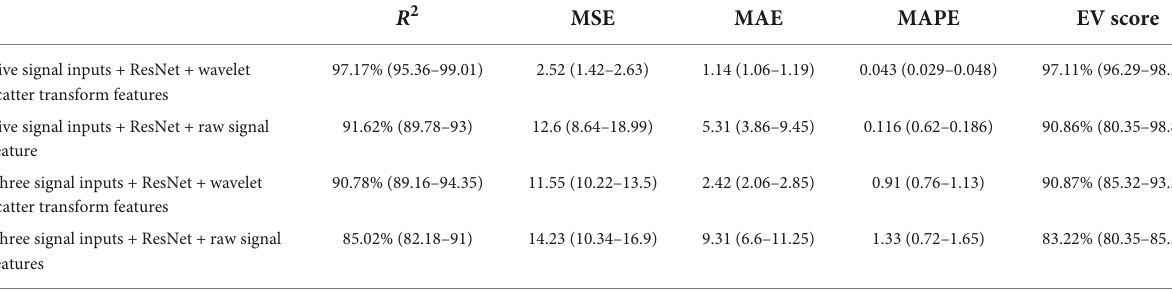
TABLE 2 The prediction performance comparison for two input groups with 95% CI.